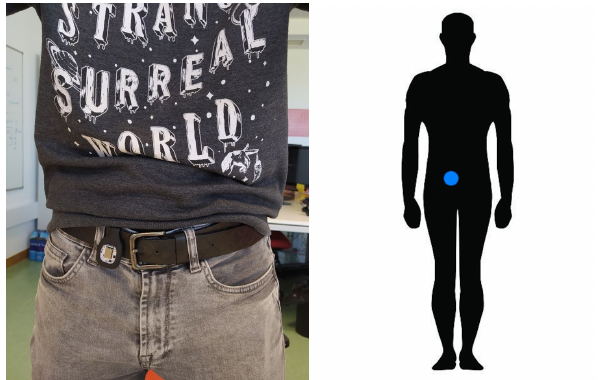
Figure 7. Location of the sensor in the user’s body.